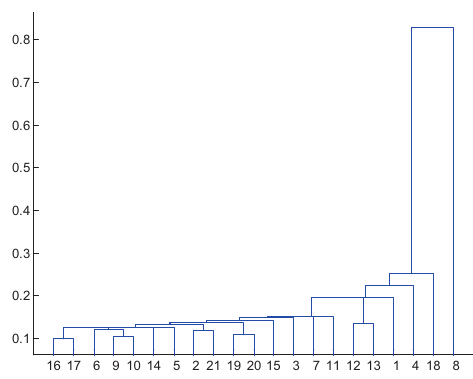
Fig. 7. Hierarchical clustering tree of the low-fault-prone network